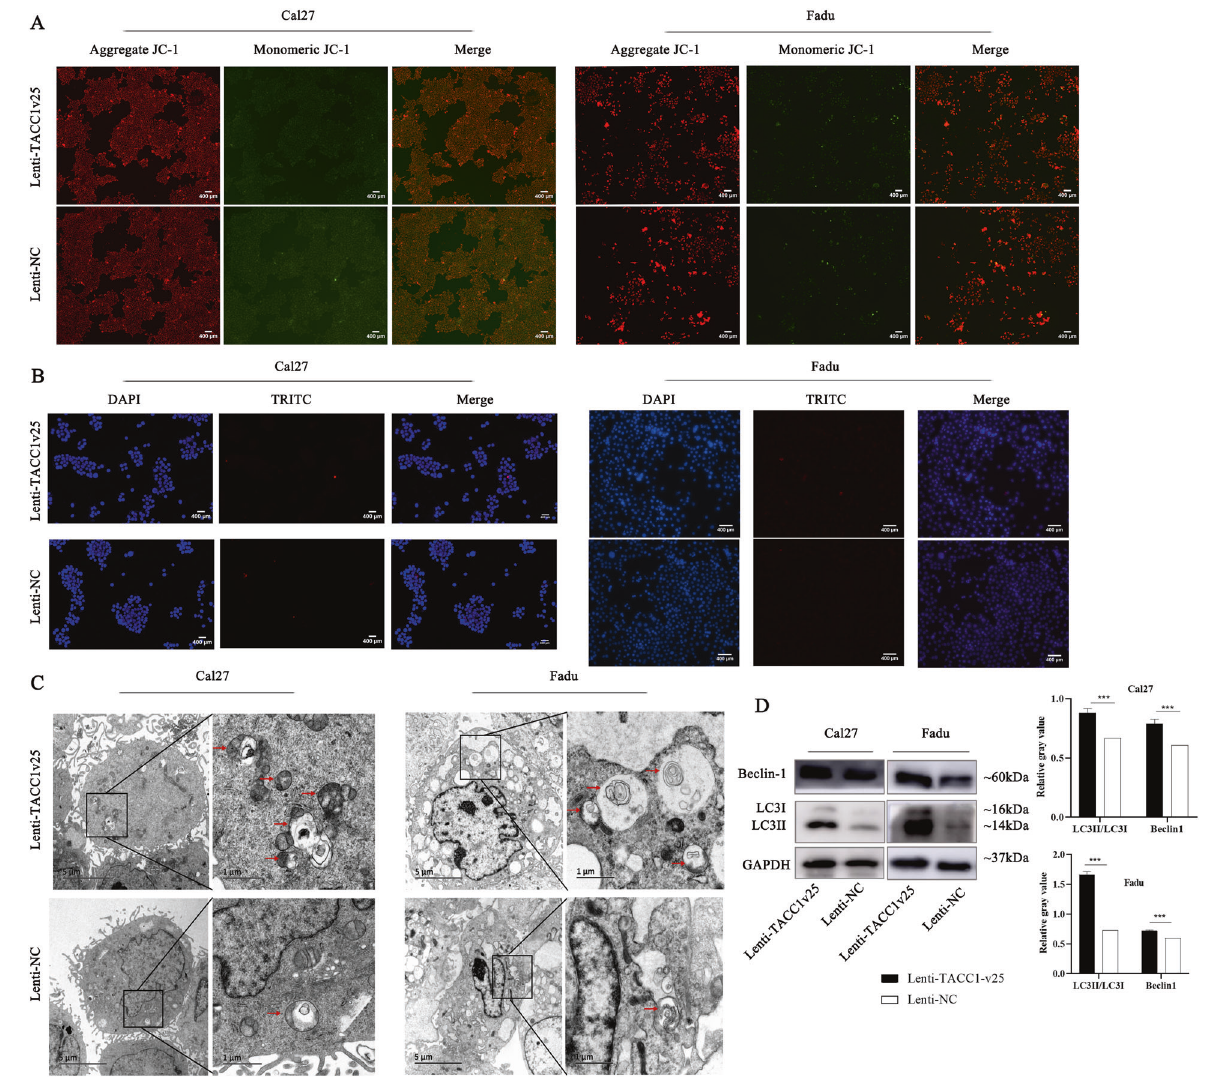
Fig. 5 TACC1v25 increases autophagy but no changes apoptosis in HNSCC cells. A Apoptosis detection using JC-1 assay. There was no signi fi cant activity of early apoptosis in Lenti-TACC1v25-Cal27/-Fadu cells and their controls. (original magni fi cation 100×). B Apoptosis detection by TUNEL assay. Late apoptosis was not observed in Lenti-TACC1v25-Cal27/-Fadu cells and their controls. (original magni fi cation 200×). C Autophagosome detection by TEM. The number of autophagosomes is increased in Lenti-TACC1v25-Cal27/-Fadu cells. D Detection of autophagy-related proteins by western blot. Autophagic markers, LC3II/I and Beclin-1 are increased in stably expressing TACC1v25 cells. Blue, DAPI; red, Apoptosis cells. * P < 0.05, ** P < 0.01, *** P <